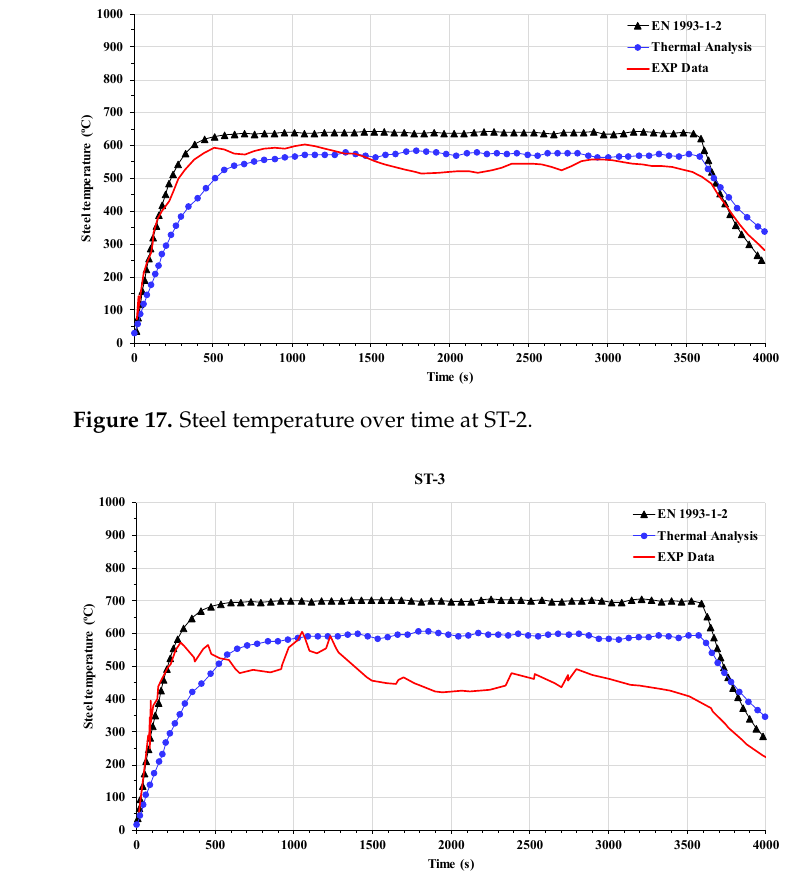
Figure 18. Steel temperature over time at ST-3.